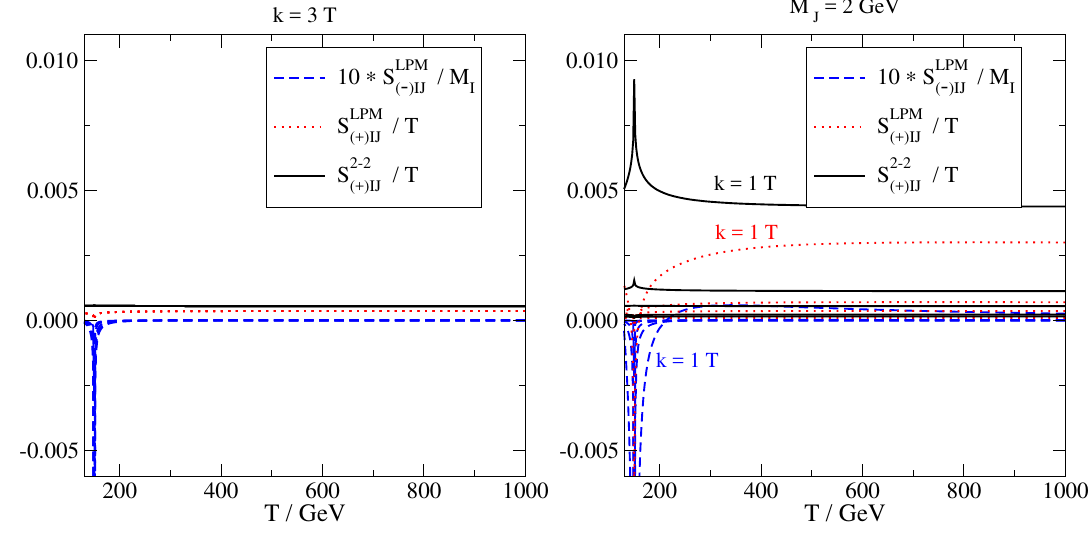
Figure 6 . Left: S from eq. (2.34), for (cid:12)xed k = 3 T and M /GeV 2 f 0 : 5 ; 1 ; 2 ; 3 ; 4 g ; the mass ( (cid:28) ) IJ J dependence is mild. Right: the same for (cid:12)xed M = 2 GeV and k=T 2 f 1 ; 2 ; 3 ; 6 ; 9 g . One curve has J been labelled, with the dependence on k=T being